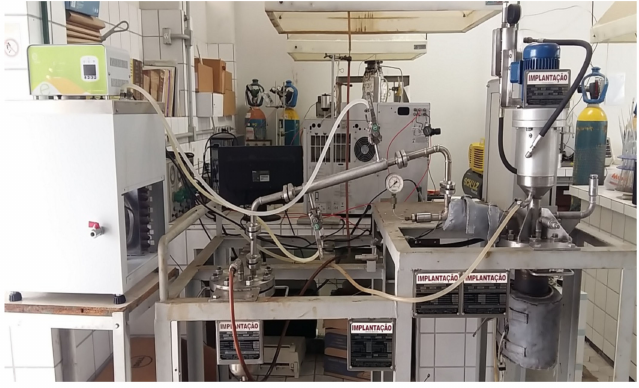
Figure 4. View of the pyrolysis unit in bench